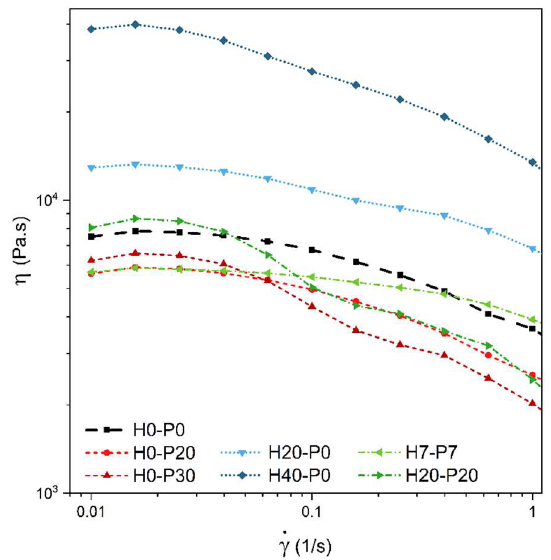
. γ ) from flow sweep rheological tests on the ) from flow sweep rheological tests on the γ(cid:3)